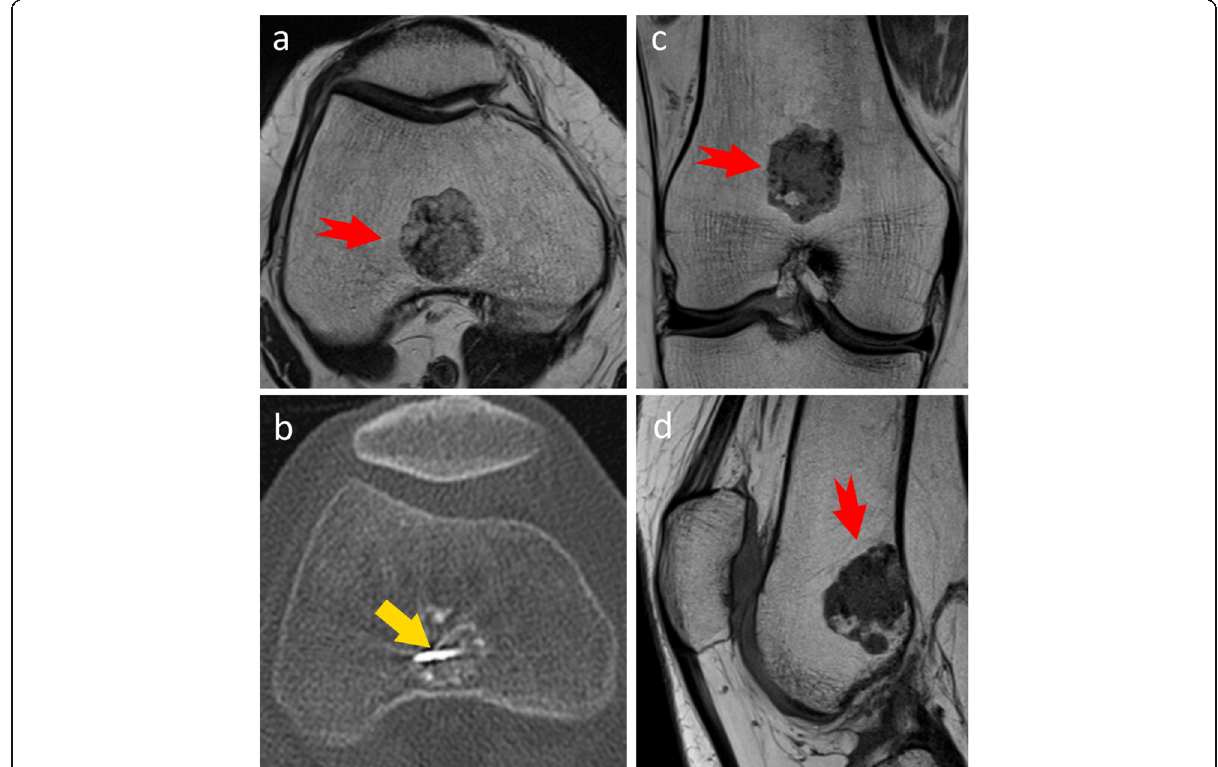
Fig. 2 a , c , and d Preoperative magnetic resonance images in different planes to evaluate an atypical cartilaginous tumour located in the metaphysis of the distal femur, with the tumour being indicated by the red notched arrow. b An intraprocedural computed tomography image demonstrating the final location of the tip of the radiofrequency ablation